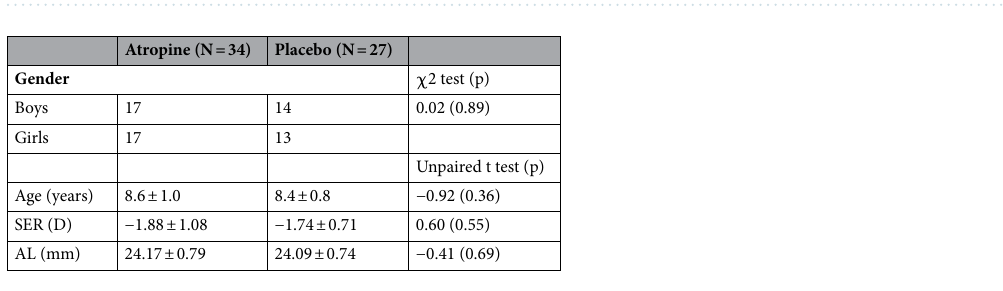
Table 1. Baseline